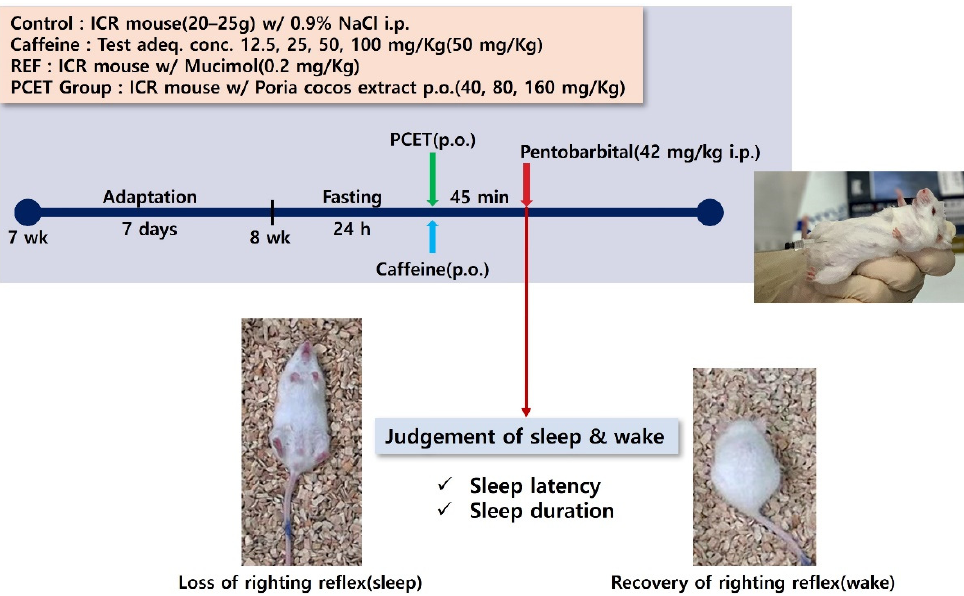
Figure 2. Conceptual diagram for evaluating the arousal-inhibiting efficacy of PCET in caffeine- induced arousal animal models. Measurement of sleep latency and sleep duration according to the oral intake of caffeine and PCET at different concentrations in mice that were sleep-induced by the intraperitoneal injection of pentobarbital.